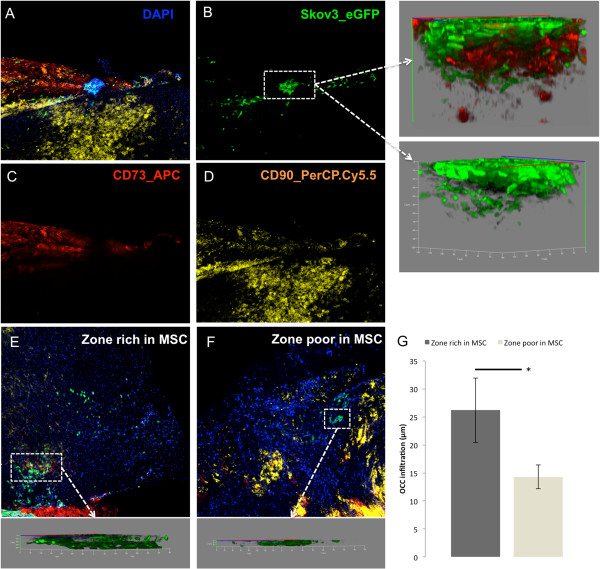
The distribution of OCC within AMS is following expression of MSC markers. A-D. Confocal microscopy tile scan reconstruction of Skov3_eGFP (green) distribution after staining with CD90 (red) and CD73 (yellow). The distribution of OCC (B) is following the distribution of CD90 (C) and CD 73 (D). Using 3D z-stack reconstruction of the tumor, we could measure the tumor depth infiltration of OCC within AMS and the relations between OCC and surrounding CD73+ amniotic stromal cells (B, arrows). E-F. Confocal tile scan reconstruction showing the distribution of OCC within AMS in regions rich in MSC (E) and without MSC (F), with their related depth of infiltration. (G). OCC infiltration was significantly increased in regions rich in MSC (*p<0.05).